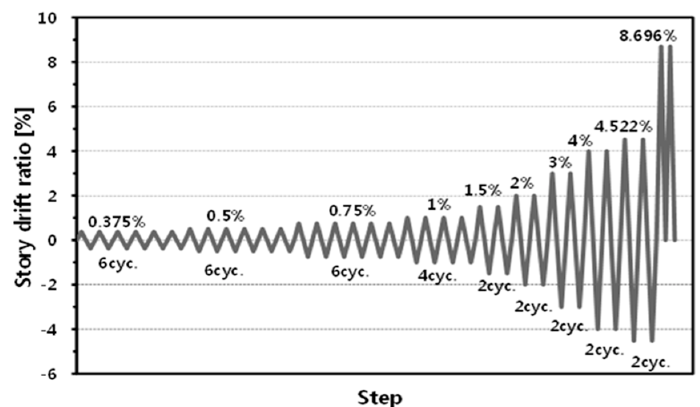
Figure 5. Cyclic loading pattern. cyc.: cycle. Table 3. Loading plan for the cyclic loading test.